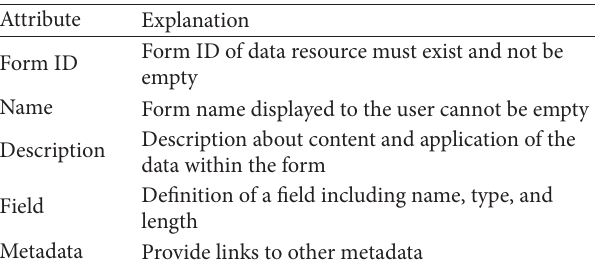
Table 2: Information of